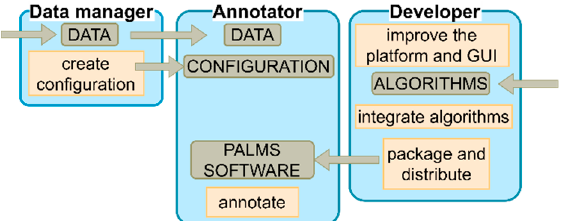
Figure 2. Different roles within the Platform for Analysis and Labeling of Medical time Series (PALMS), for each role the responsibility is depicted in the orange boxes, required information in gray boxes, and the information direction is given by the arrows. GUI—graphical user interface.